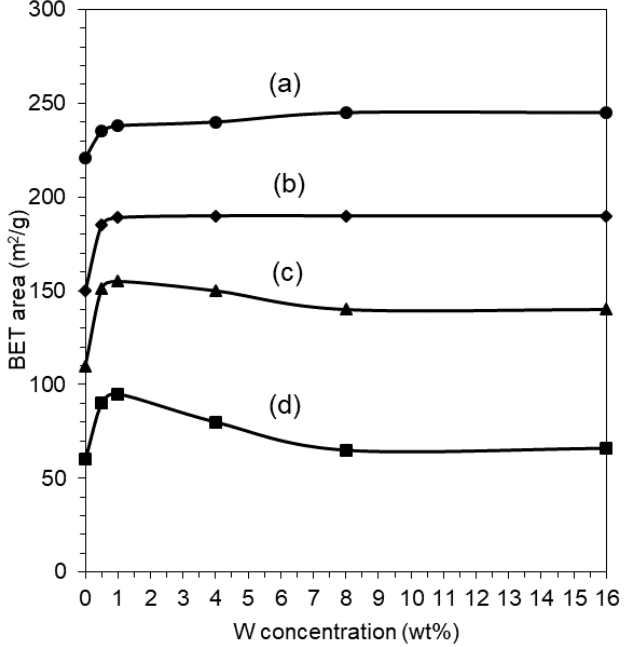
Figure 4. Effect of the W concentration on the BET area of the 25SA‒WO x samples calcined at ( a ) 550 °C, ( b ) 650 °C, ( c ) 750 °C and ( d ) 950 °C.